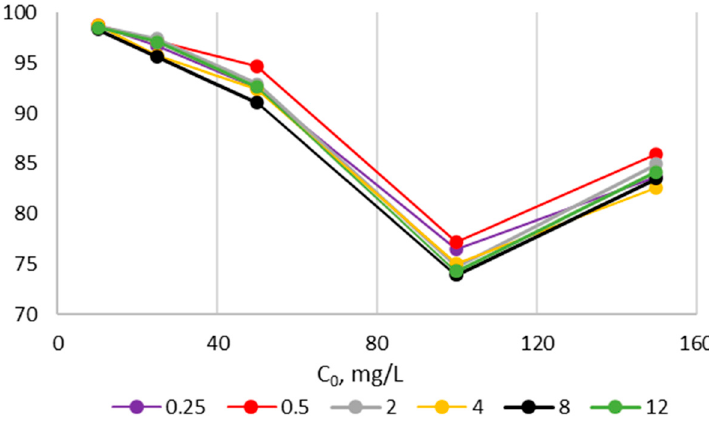
Figure 5. Removal percent of Cu 2+ on NP at pH ~3.5 and water-peat ratio 100:1; contact time is shown at the bottom in hours. Statistical spread in R values amount 3%.